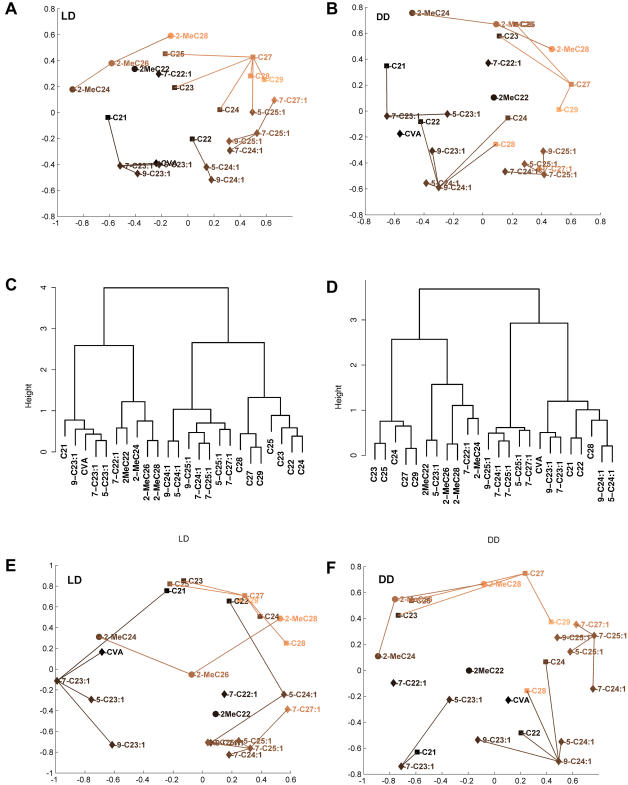
Cluster analyses of 22 CHs in LD and DD.Two independent fitted values per treatment (FA-normalized mean and FA-normalized slope βj) are used. Clusters based on mean data are shown in A-D, clusters based on slope data, E–F. A,B: MDS/AP clusters of FA-mean data in LD and DD. X and Y axes are multidimensional scaling projections of the 22-dimensional correlation distance matrix into two dimensions. Compounds are joined by a line to a central “exemplar” cluster member if the Affinity Propagation clustering algorithm of Frey and Dueck places them in the same cluster. Different clusters may overlap in this 2-D representation, as two dimensions is not sufficient for MDS projection to capture all of the variation in the data; the AP clusters are determined from the full 22-dimensional structure, which has 4 significant principal components. C,D: Ward's minimum variance clustering of wild-type FA-mean data in DD and LD. E,F: MDS/AP clusters of FA-slope values βj in LD and DD.